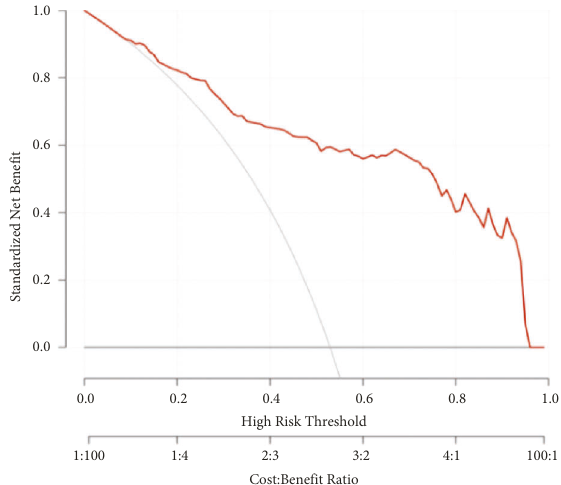
Figure 7: Decision curve tested using all the nodules. It shows higher net benefit across all the risk threshold compared to treat-all and treat-none